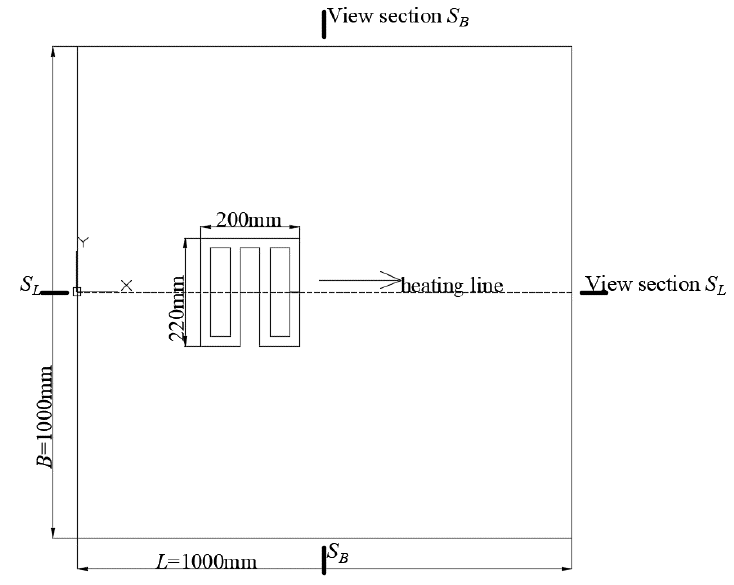
Figure 6. Heating line, moving direction, and view sections.